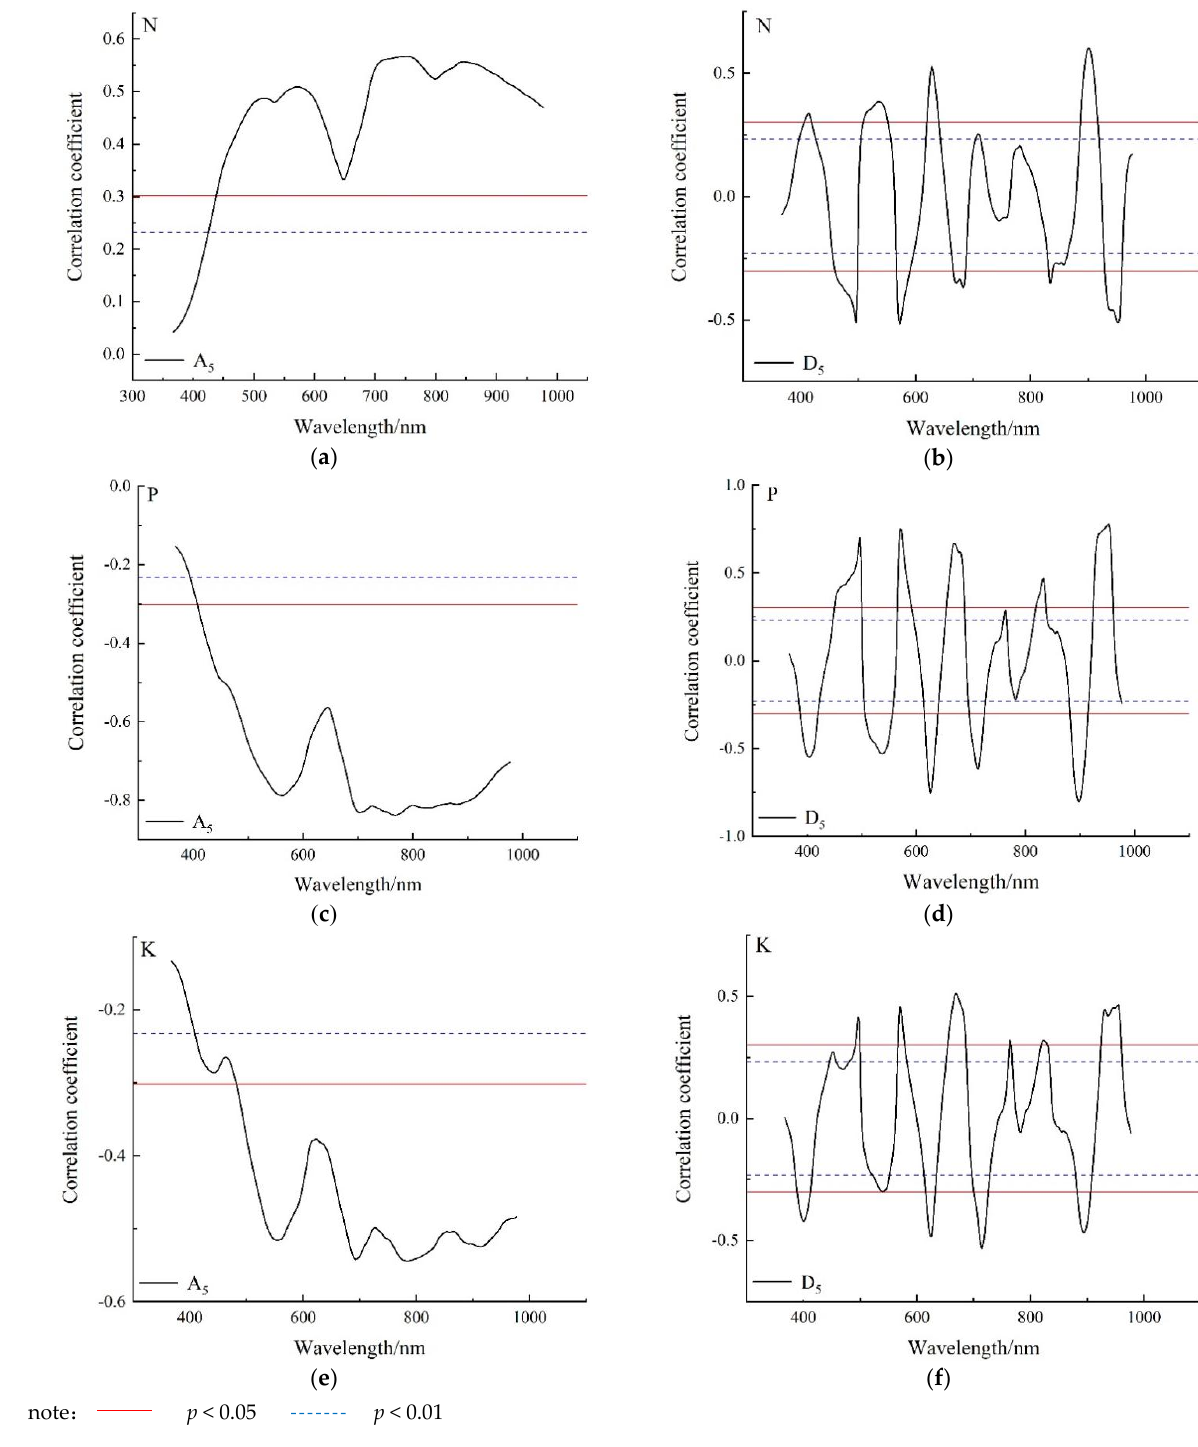
Figure 5. Correlation analysis of nitrogen, phosphorus and potassium contents with db 5 low-frequency wavelet coefficients (A 5 ) and high frequency wavelet coefficients (D 5 ). ( a ) Correlation curve between nitrogen content and low frequency A 5 wavelet coefficients. ( b ) Correlation curve between nitrogen content and D 5 high frequency wavelet coefficient. ( c ) Correlation curve between phosphorus content and low frequency A 5 wavelet coefficients. ( d ) Correlation curve between phosphorus content and high frequency D 5 wavelet coefficients. ( e ) Correlation curve between potassium content and low frequency information A 5 . ( f ) Correlation curve between potassium content and high frequency information D 5